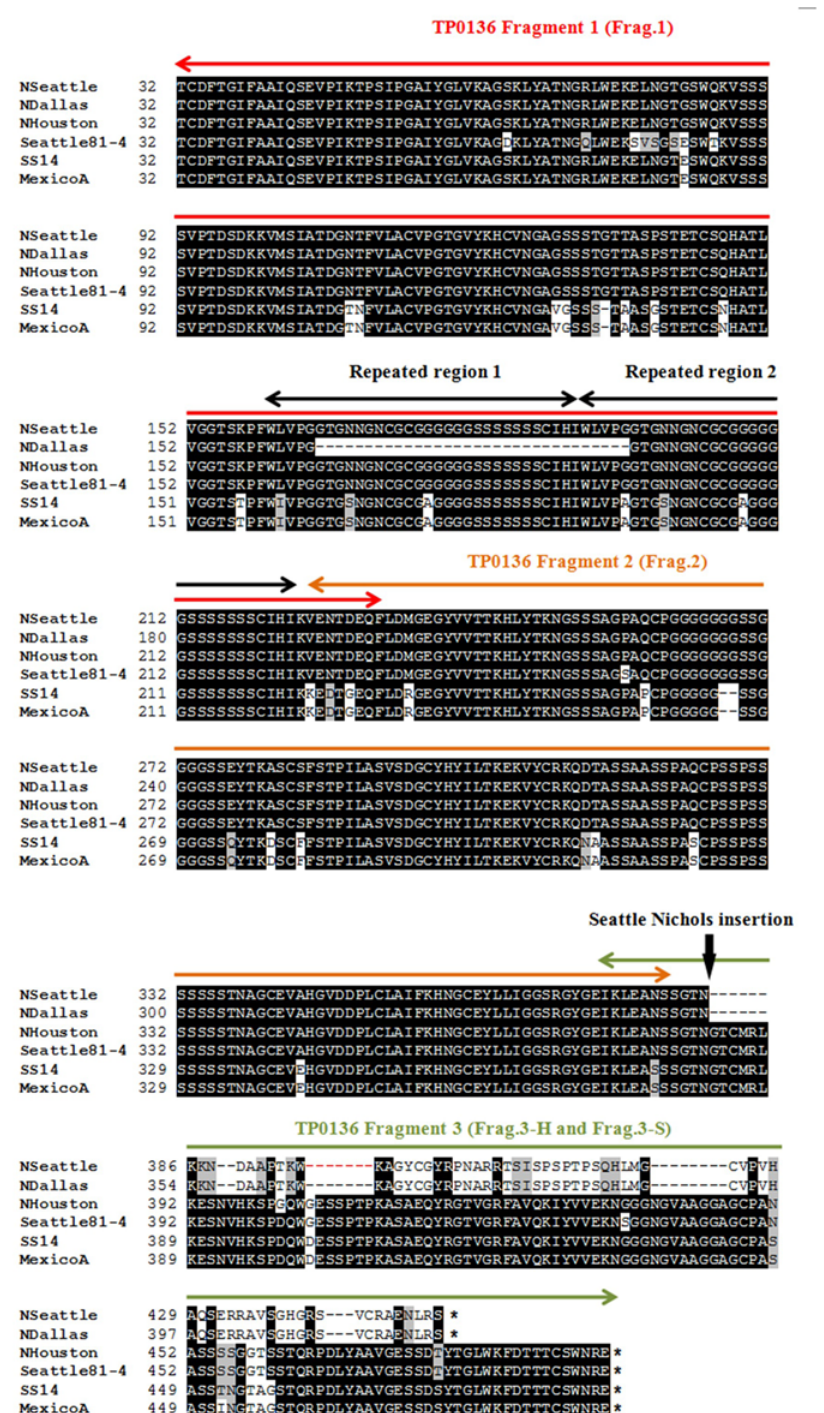
Fig 1. Comparative analysis of predicted TP0136 proteins. Predicted amino acid sequences of TP0136 (without aa 1 – 31, belonging to the signal peptide) from eight T . pallidum strains (Nichols Houston, Nichols Seattle, Nichols Dallas, Dal-1, MexicoA, Bal73 – 1, Seattle81 – 4, and SS14). Only one sequence representative of each identified TP0136 variant is represented here. Black shading indicates 100% sequence identity, gray shading reflects functionally similar amino acids, and no shading is indicative